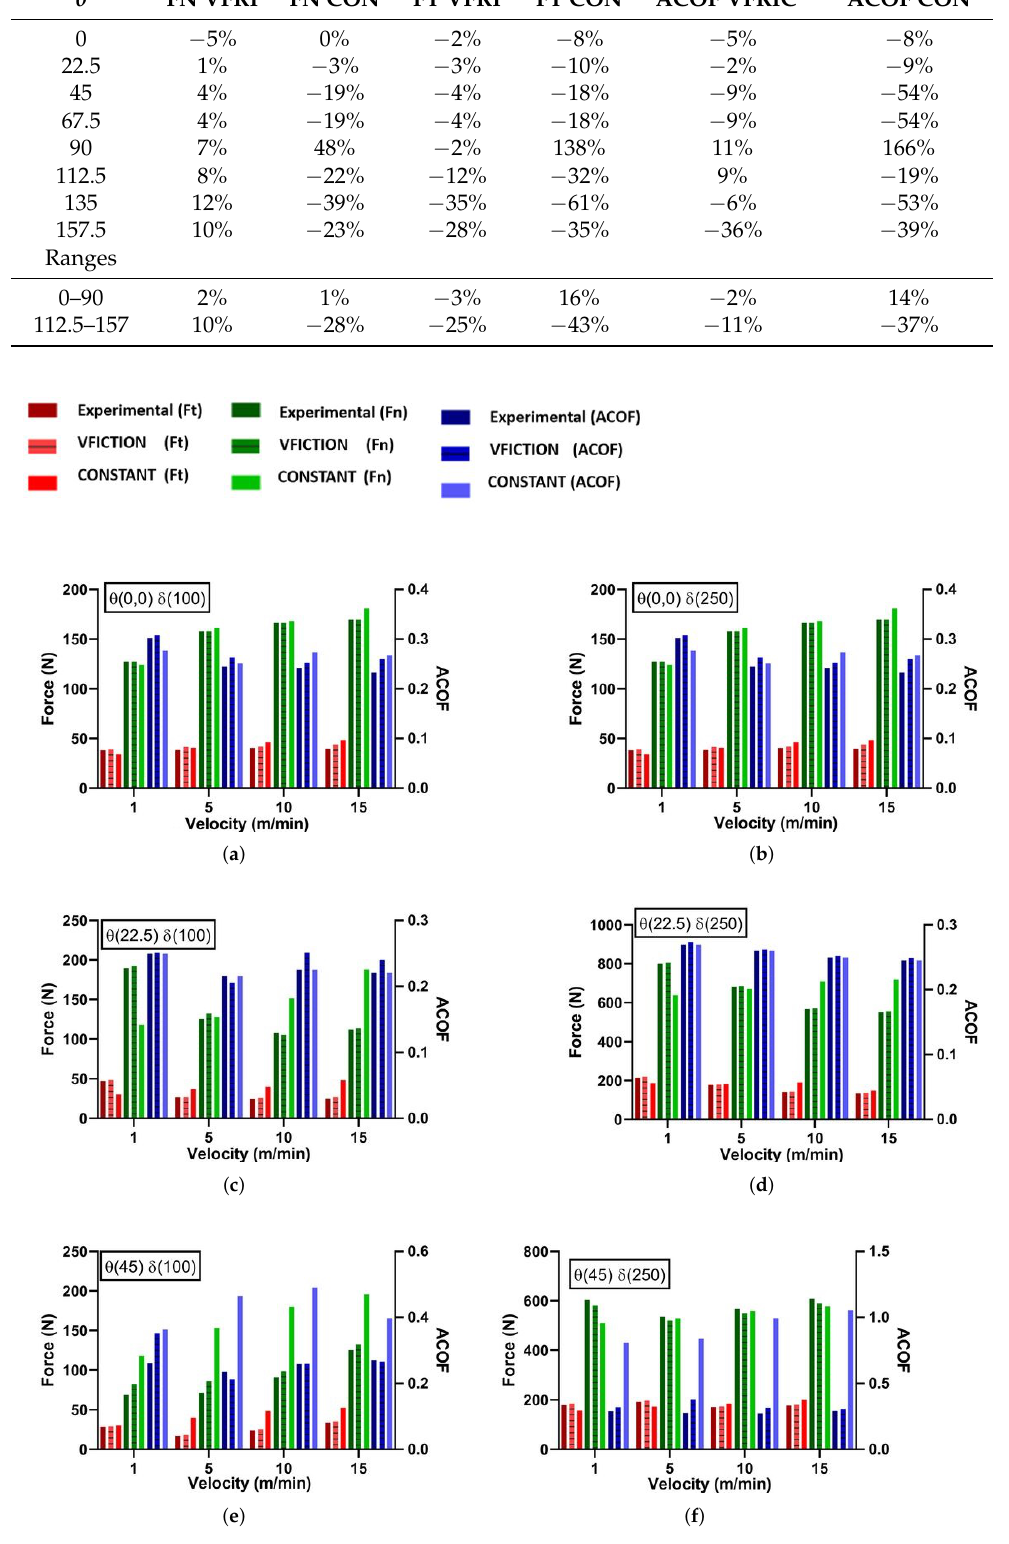
Figure 11. Experimental Results: FE Comparison of Dynamic Friction Model vs. Constant Friction Coefficient for Open-Loop